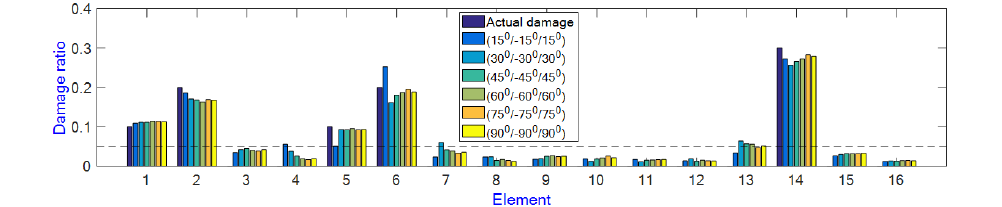
Fig. 8. Damage identi(cid:28)cation results obtained by damage indicator MKECR for damage scenario C of the clamped-clamped cross-ply